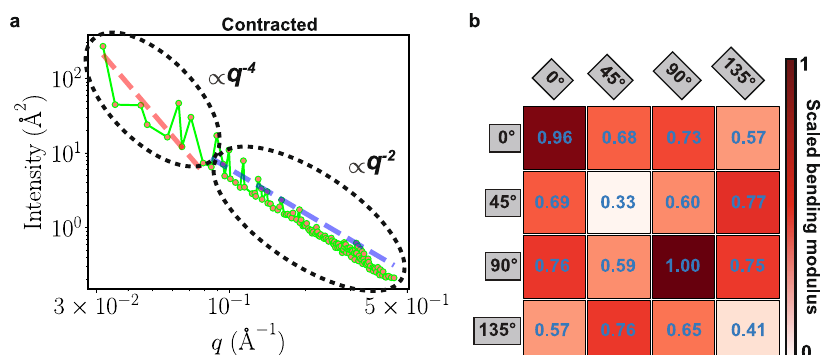
Fig. 4 | Membrane bending moduli calculated for different arrangements of contracted prestin. a Intensity, ∣ h ( q ) ∣ 2 plotted vs. q , wavenumber, for the system with two prestin dimersboth at135° ([135°, 135°]). The plot isin log-log format and contains two regions: (1) free-undulation ( fi tted to the q − 4 line shown in red) and protrusion( fi ttedtothe q − 2 lineshowninblue).The fi ttothefree-undulationregion is used to calculate the bending modulus. Source data are provided as a Source Data fi le. b Bendingmoduliforthemembraneswithtwoprestindimersindifferent